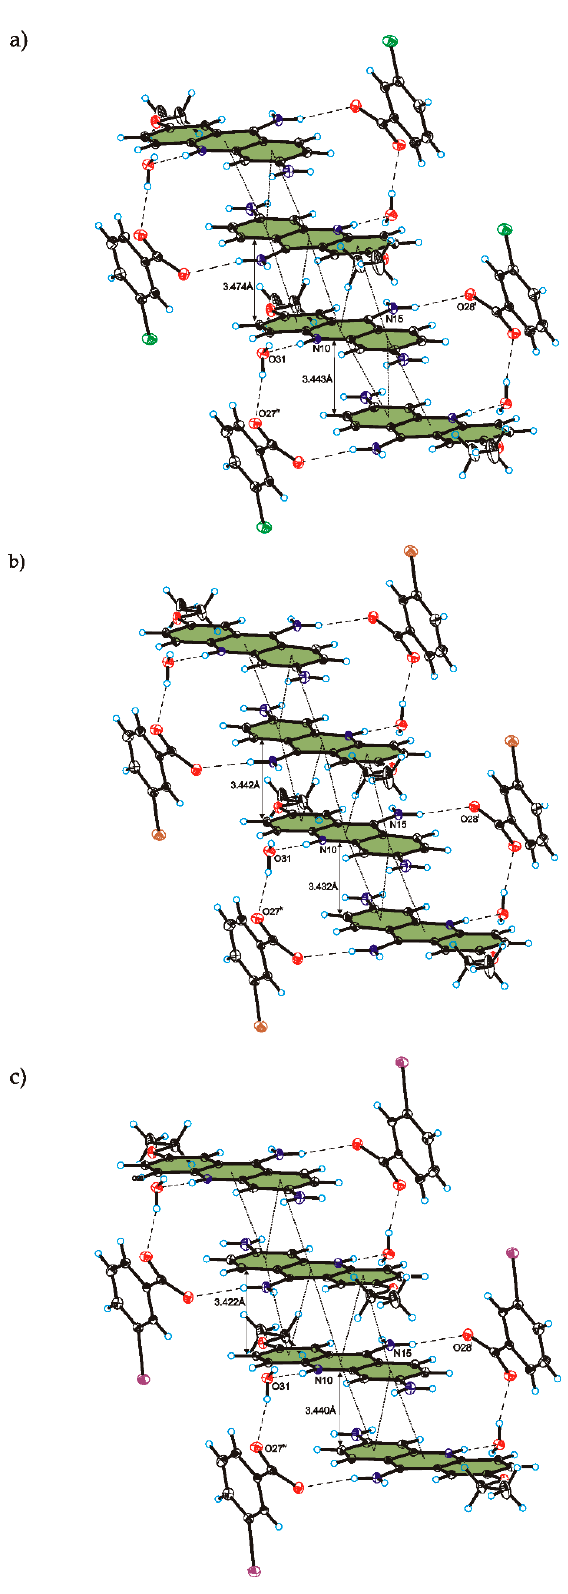
Figure 2. Heterohexamers formed by ethacridinium cations, meta -halobenzoate anions and water molecules and π – π stacking interactions between them in compounds 1 – 3 shown in ( a – c ), respectively (hydrogen bonds are represented by dashed lines, whereas π – π stacking interactions are represented by dotted lines).